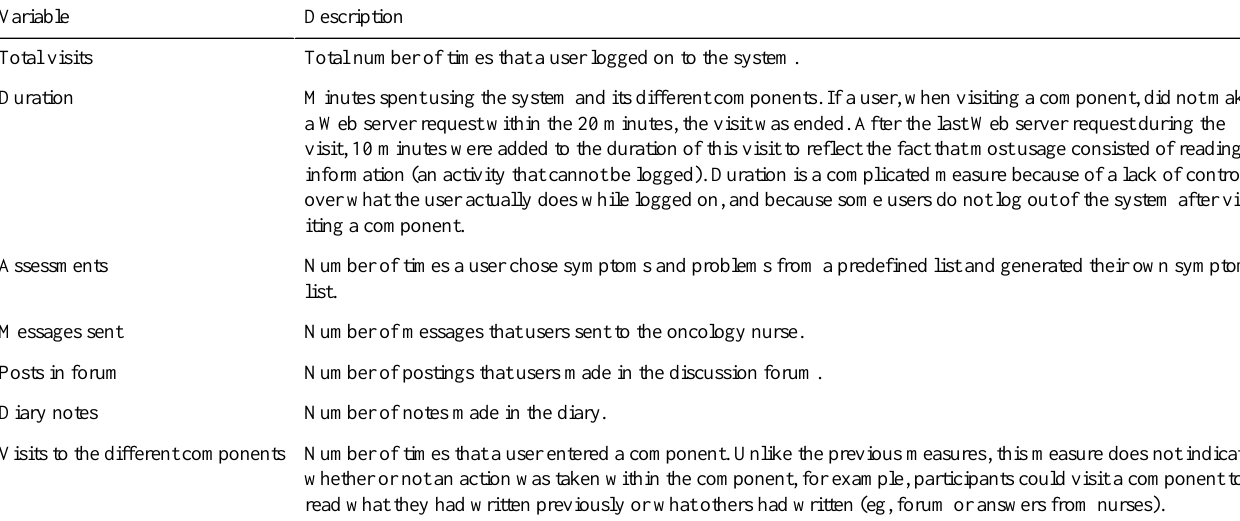
Table 1. Measures of system use of the WebChoice